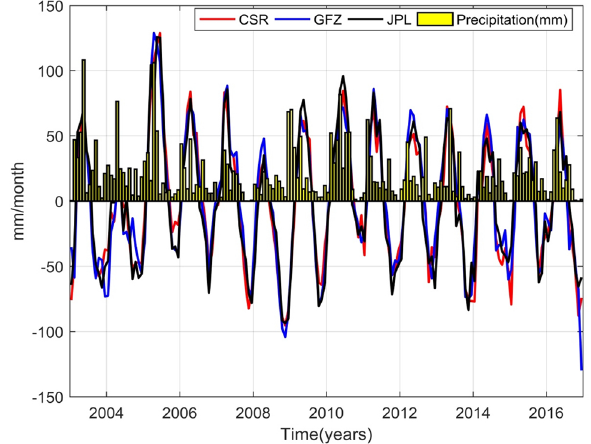
Fig. 6 Mean monthly precipitation (mm/month) and mean monthly GRACE TWS (CSR, GFZ, JPL) and GLDAS-Noah model of GB during 2002–2016